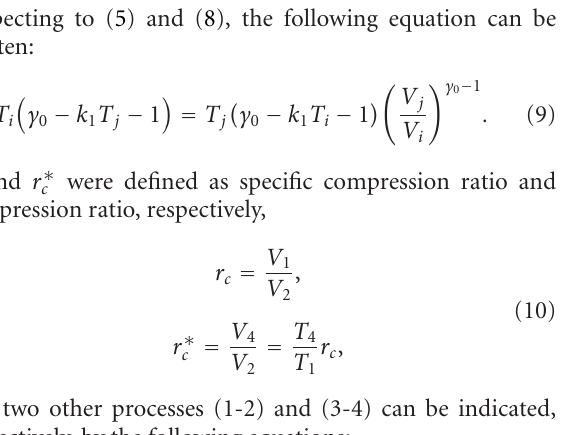
Figure 3: T-S diagram of real air standard Atkinson